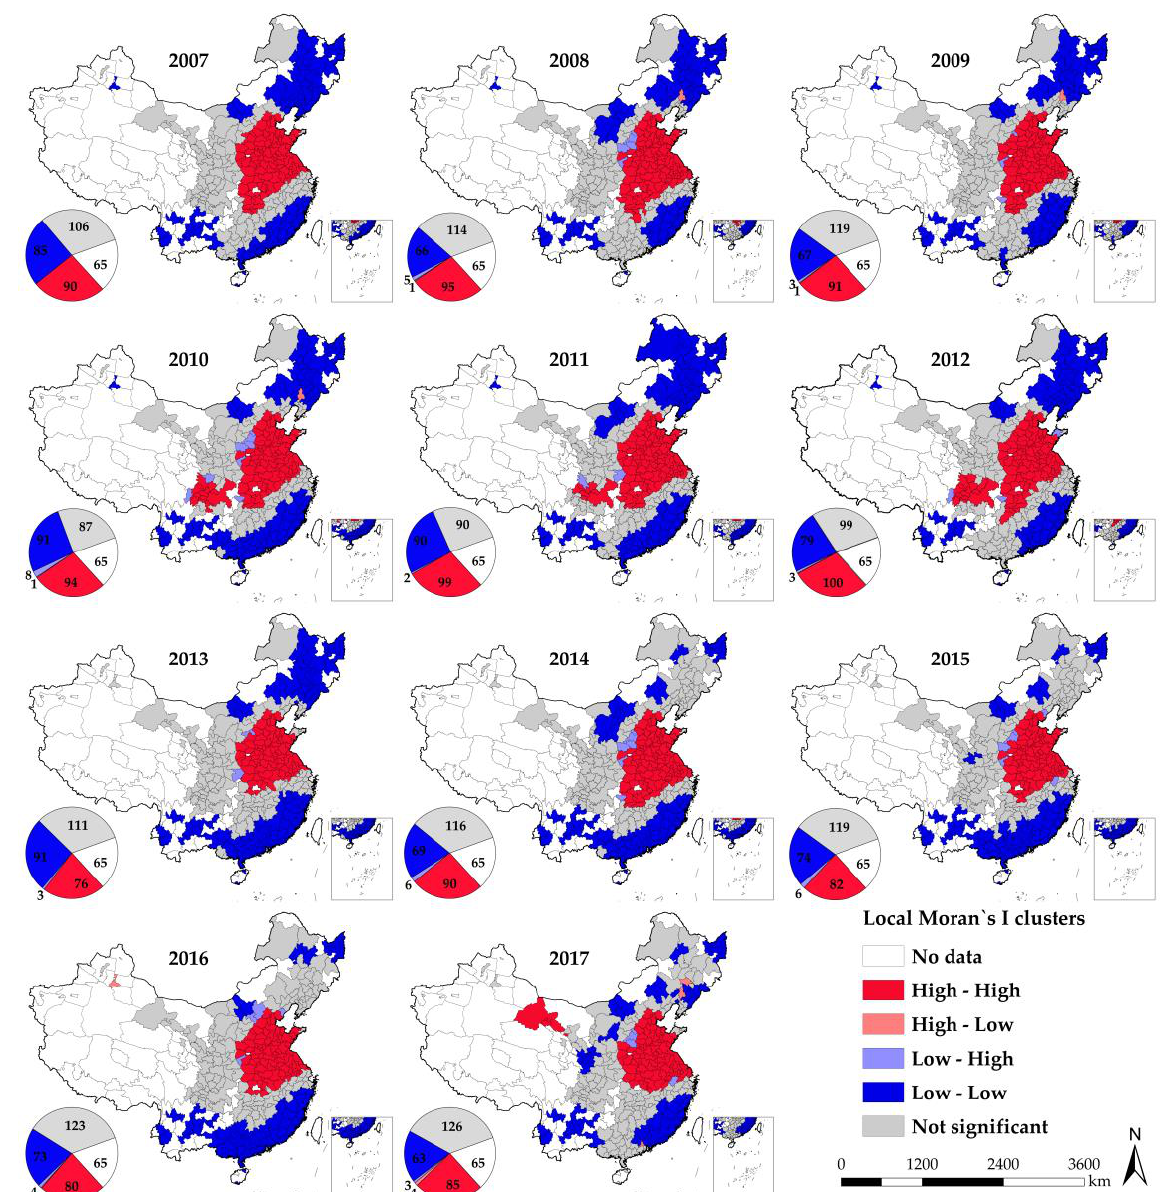
Figure 4. Local autocorrelation map of China’s PM 2 . 5 pollution.